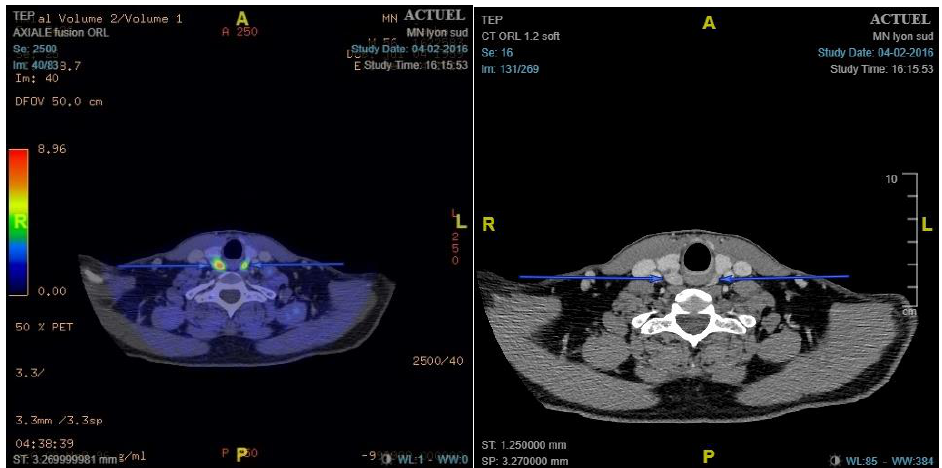
Figure 1. Example of true positive bilateral pathologic gland. 18 F-choline positron emission tomography/contrast-enhanced computed tomography shows two nodular areas with hypermetabolism: left maximum standardised uptake value (SUVmax), 5.16; right SUVmax, 7.10. Pathology showed two adenomas: right weighing 4620 mg and left weighing 610 mg.